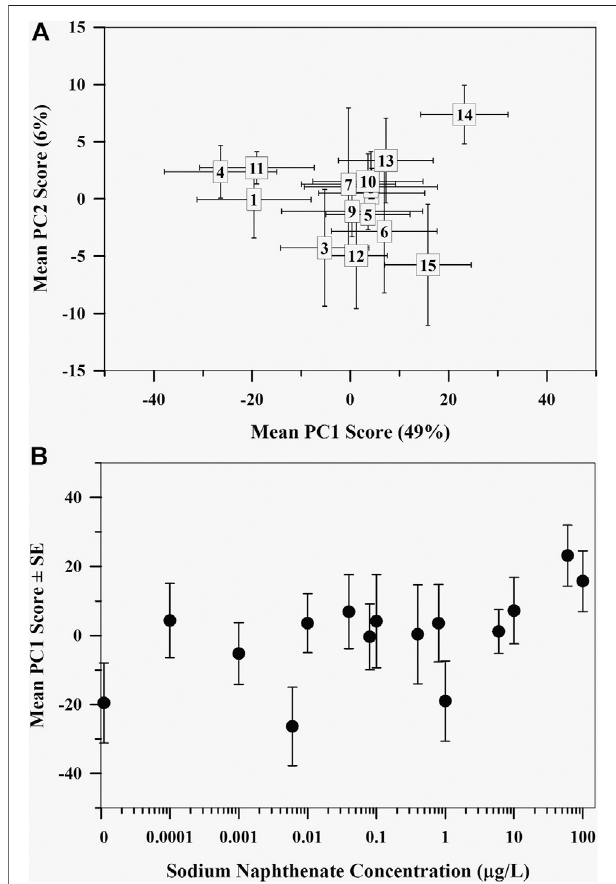
FIGURE 2 | (A) Mean principal component scores of the may fl y ( Hexagenia spp.) nymph metabolome exposed to sodium naphthenate. Numbers represent exposure from lowest 0 μ g L − 1 (1) to highest 100 μ g L − 1 (15) sodium naphthenate concentrations. Error bars indicate ± one standard error of the mean. (B) Mean fi rst principal component scores of the may fl y ( Hexagenia spp.) nymph polar metabolome exposed to sodium naphthenate concentrations (0, 0.0001, 0.001, 0.006, 0.01, 0.04, 0.08, 0.1, 0.4,0.8,1,6,10,60,and100 μ g L − 1 ).Errorbarsindicate ± onestandarderror of the mean. Note the logarithmic scale in concentration along the x